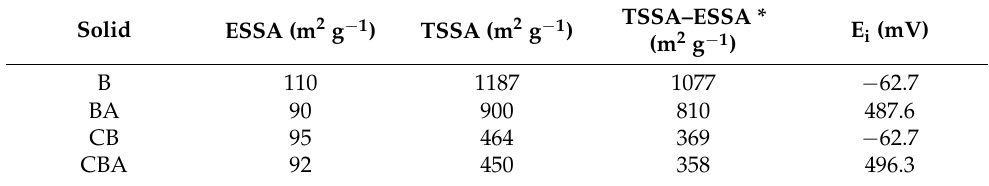
Table 2. Total and external specific surface area of the solids and results of potentiometric titration.